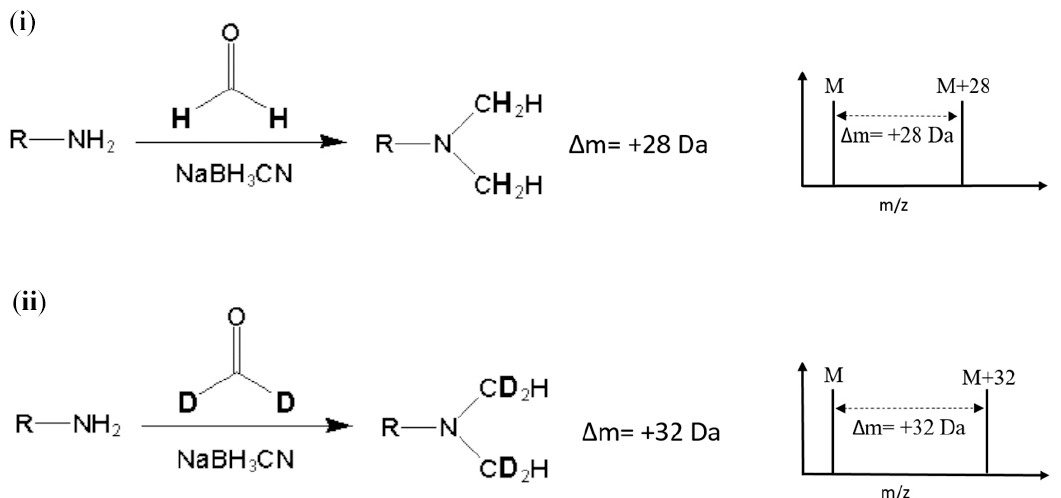
Figure 1. Reaction and m / z shift of ( i ) light (hydrogen) and ( ii ) heavy (deuterium) stable-isotope dimethyl labeling. R represents the remainder of the peptide and M represents the m / z of the native peptide with a single charge.